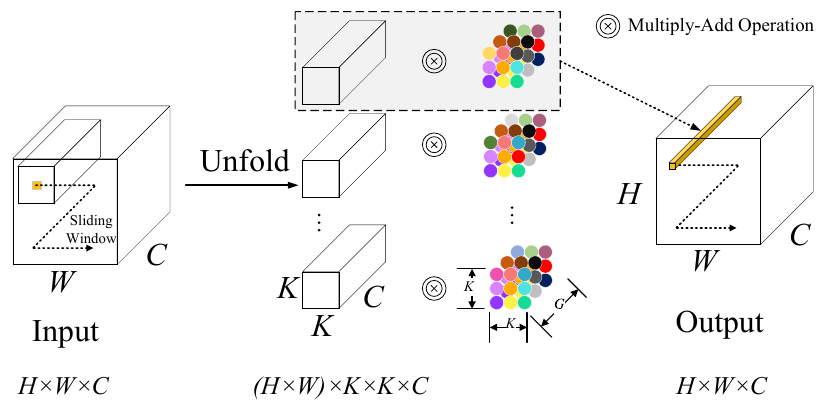
Figure 6. The unraveled view of